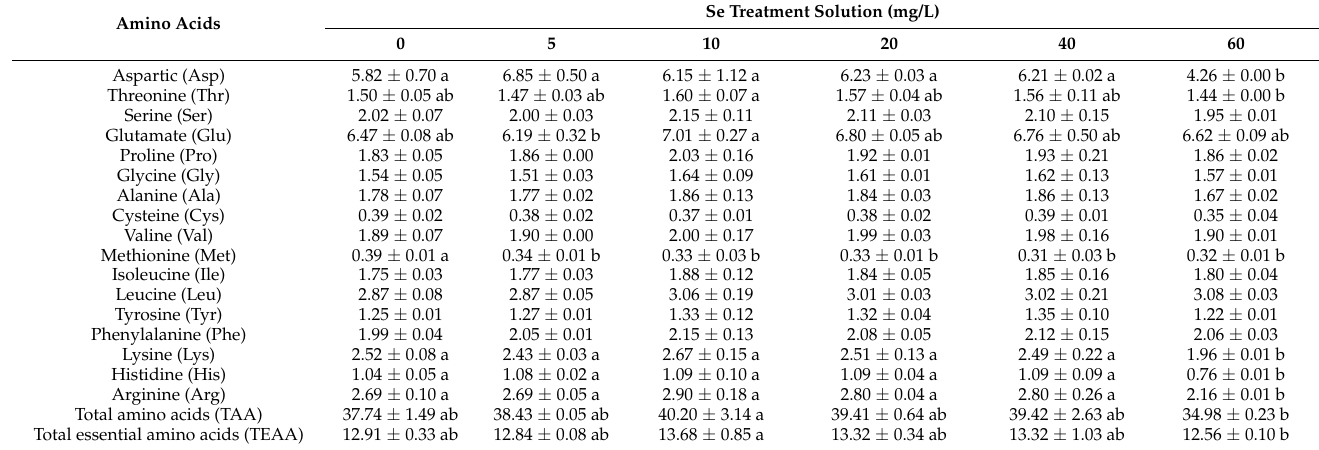
Table 3. Total protein concentration during soybean germination with different concentration Se treatment. Amino